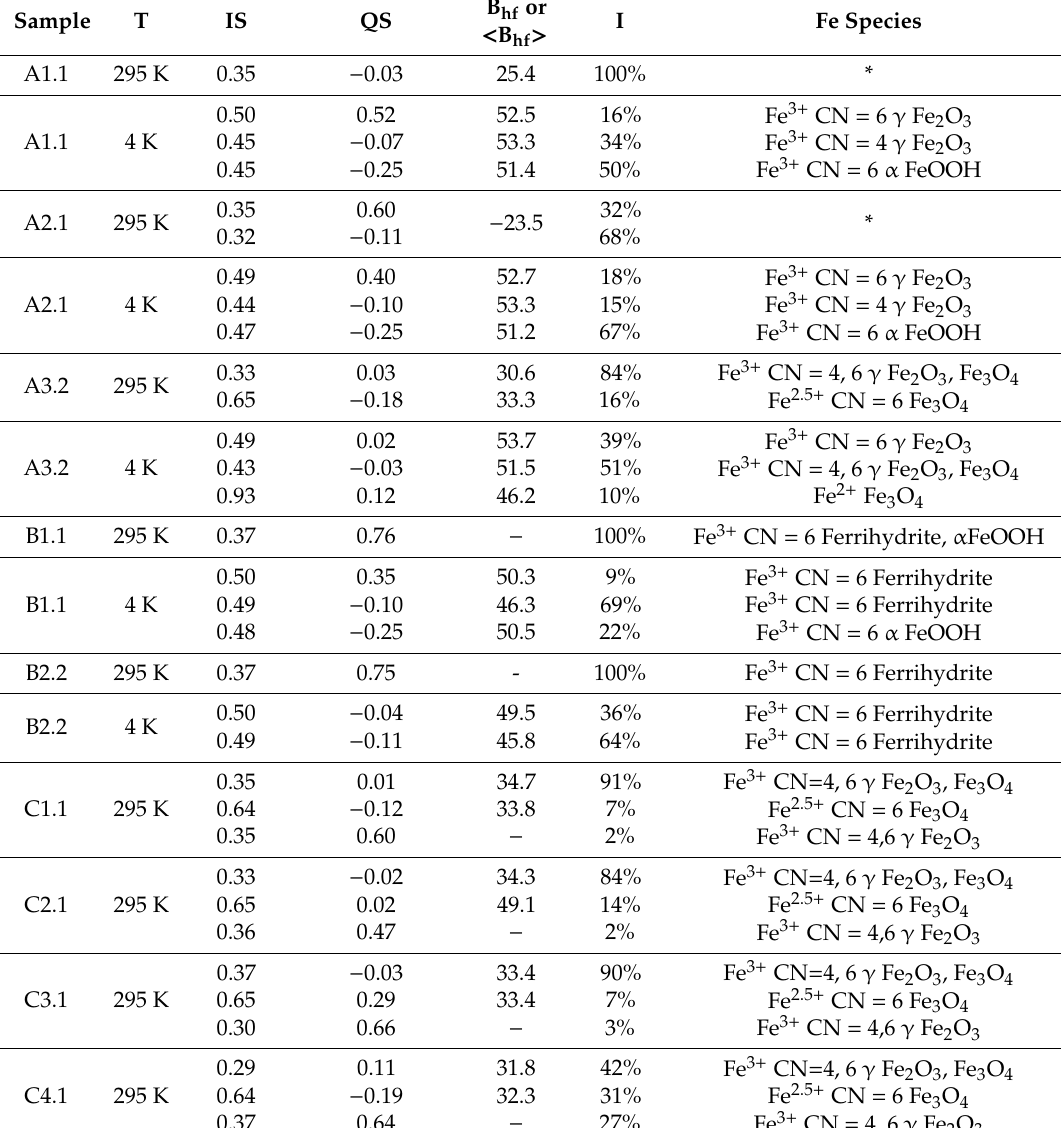
Table 4. Estimated parameters from the Mössbauer spectra of the naked and coated SPION samples, taken at di ff erent temperatures